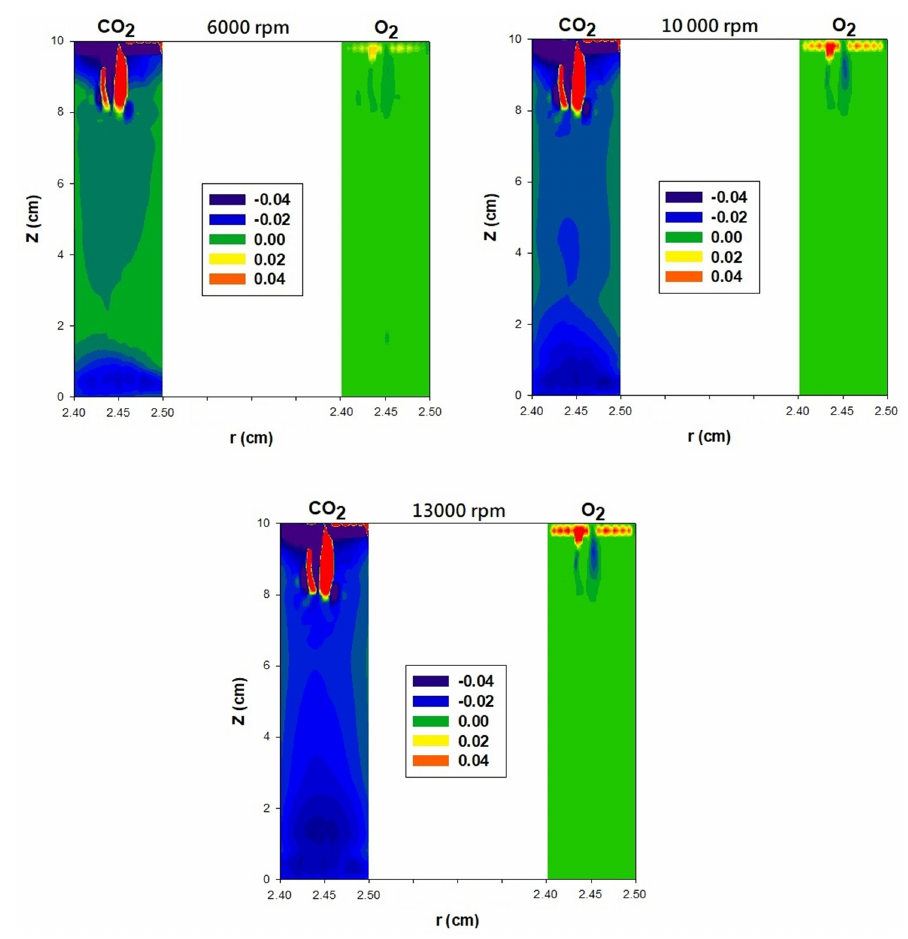
Figure 7. Computational fluid dynamic–simulated CO 2 and O 2 flow fields of APM at various rotation speeds.